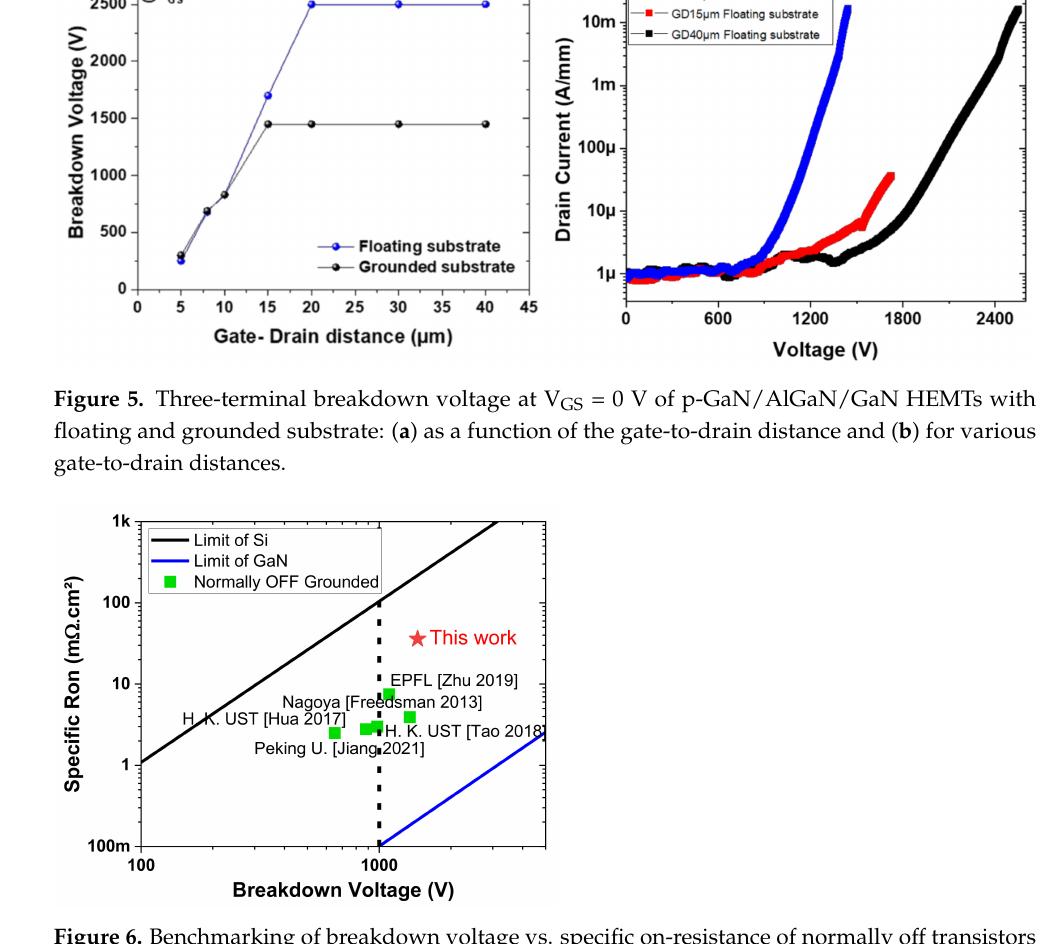
Figure 6. Benchmarking of breakdown voltage vs. specific on-resistance of normally off transistors with a grounded substrate. Solid lines in black and blue represent the theoretical limits of Si and GaN,